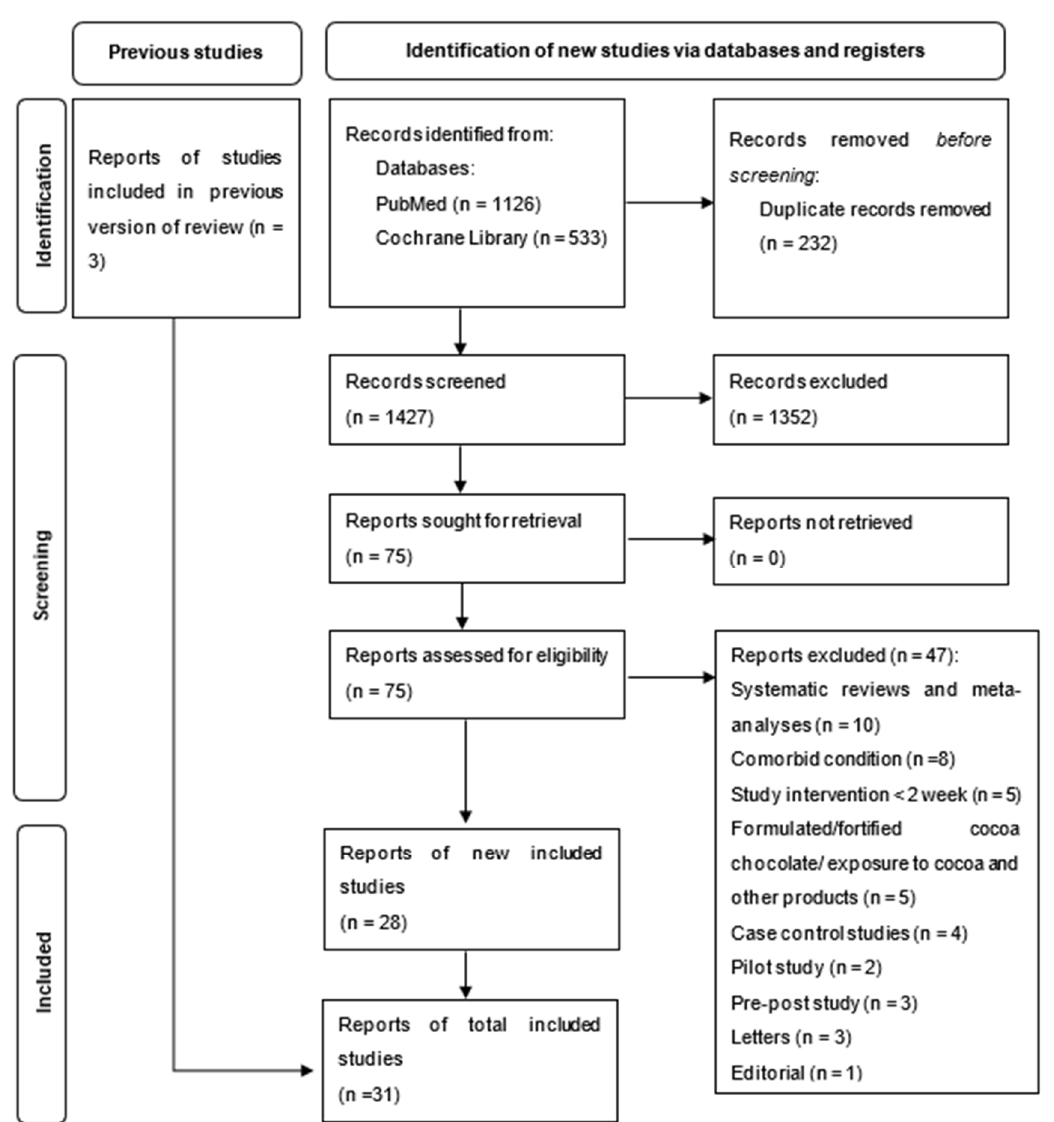
Figure 1. Flowchart summarizing studies evaluated and selected for the systematic review.